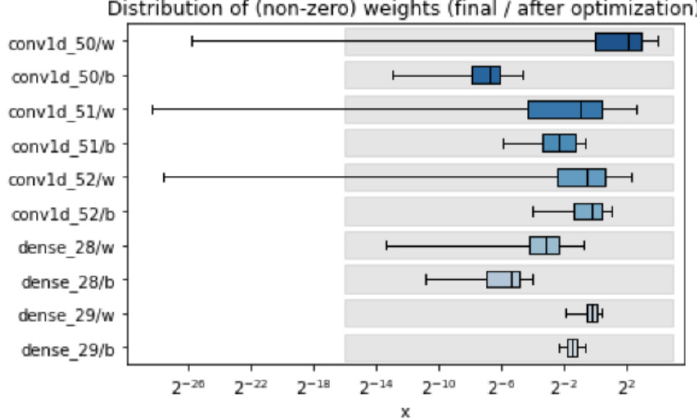
Figure 10. Bit selection using numerical profiling.